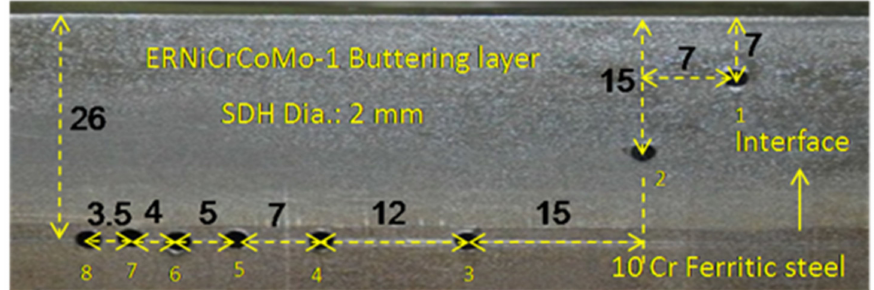
Figure 3. Photograph of the reference block used in the present study. The depths of the side drill holes (SDHs) and their relative distances are given in